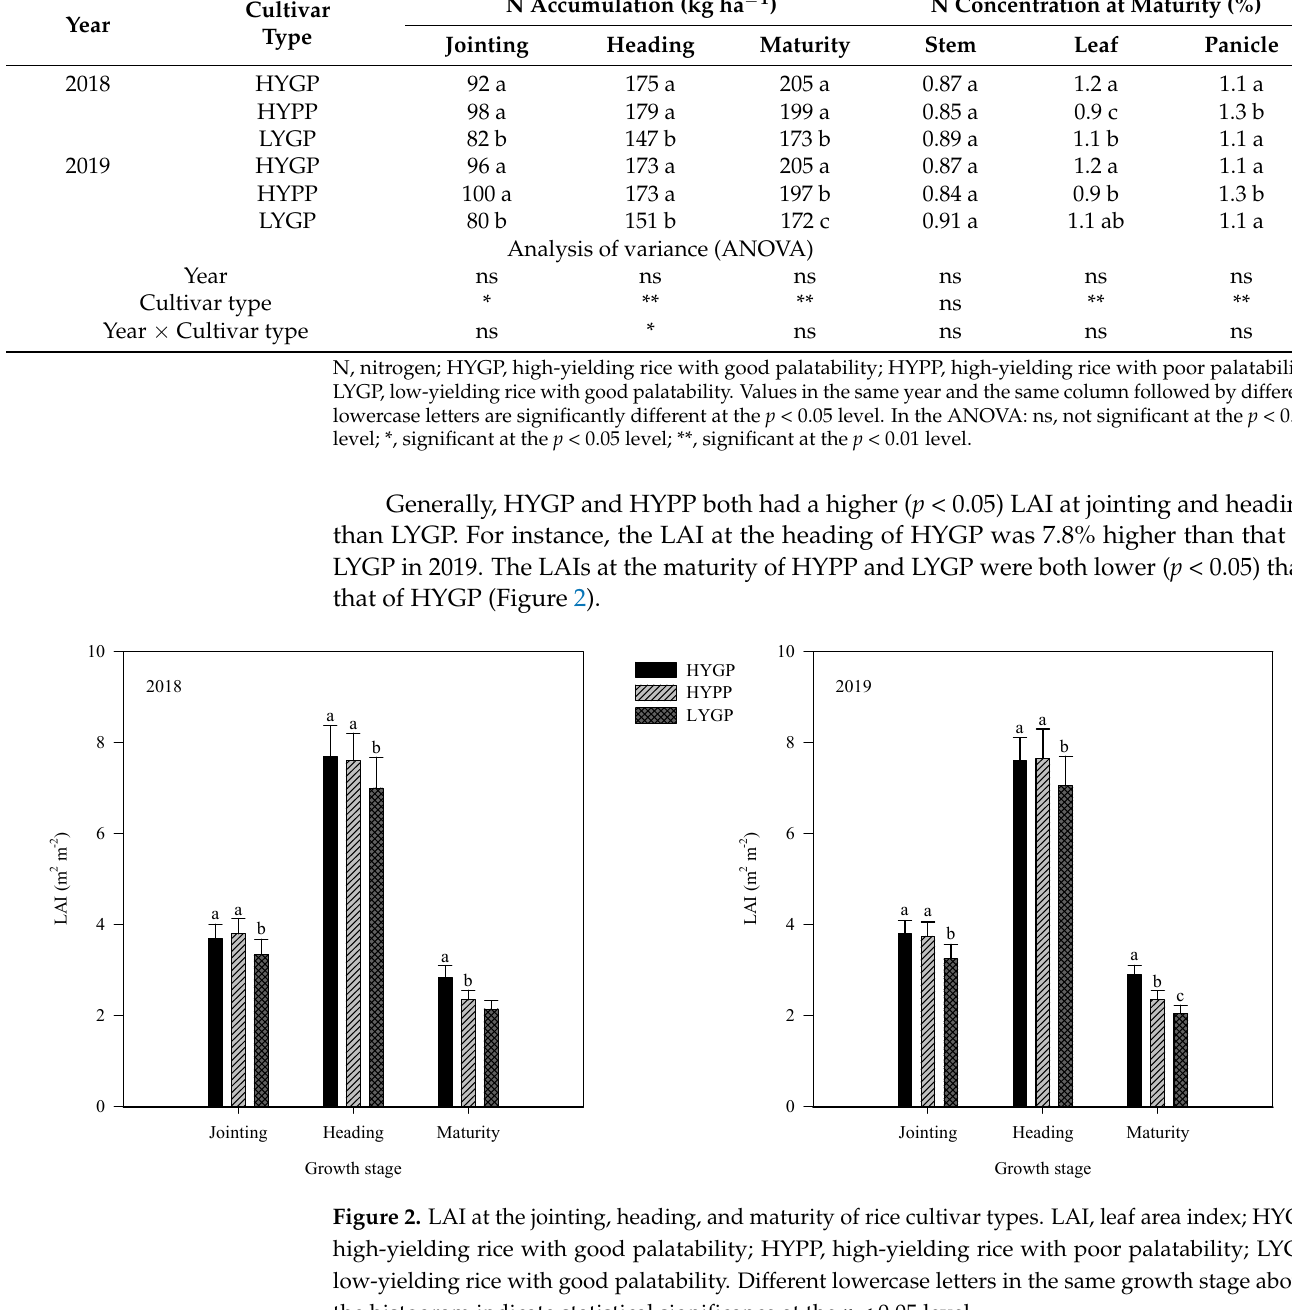
Table 4. N accumulation at the main growth stages and plant N concentration at the maturity of rice cultivar types.